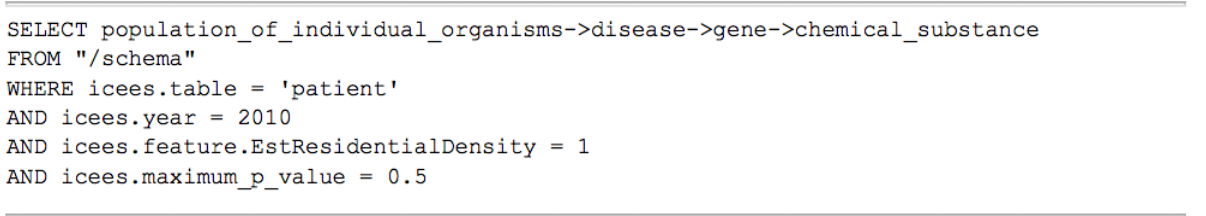
Figure 5. TranQL query for use case 2.